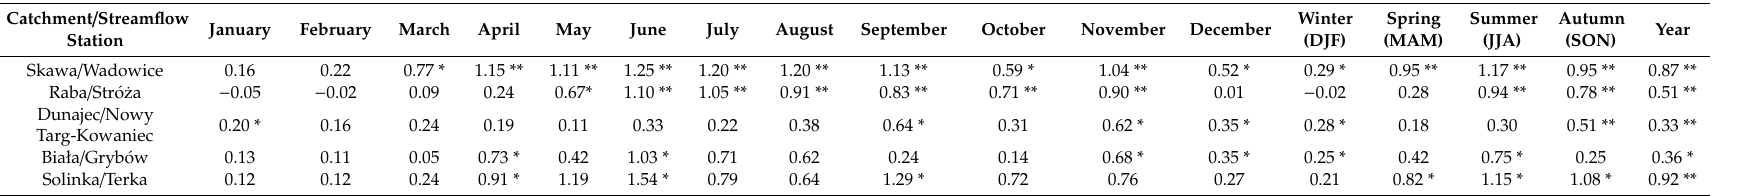
Table 3. Trend intensity ( ◦ C per decade) in water temperature (TW) for each month, each season (1984–2018), and for the annual means (the last column). Catchment / Streamflow